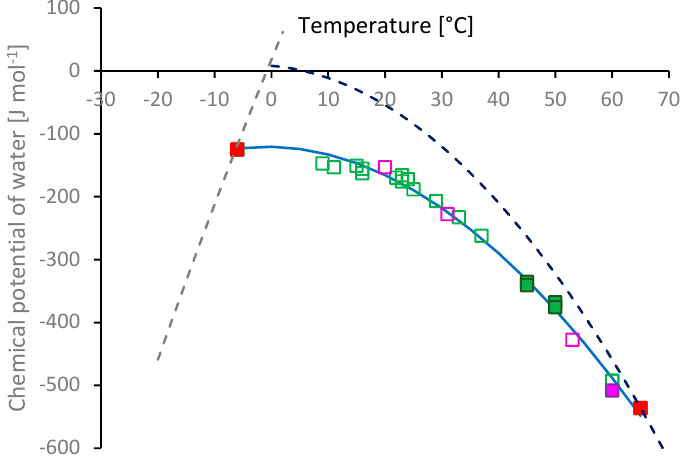
Figure 10. Chemical potential vs. temperature for ice (grey dashed, Equation (7a)), liquid water (blue dashed, Equation (7b)), cloud points in salt solutions (open squares) and the aggregation onset points observed by DLS or SAXS (filled squares). Green points were obtained for NaCl solutions; magenta indicates KCl solutions. The gelation points at high and low temperature, observed by rheology (red), are assumed to indicate where the chemical potential of the hydration shell is equal to that of water or ice. The uncertainty in the experimental data is expected to be similar to the sizes of the symbols. Subsequently, an estimate for the chemical potential of the hydration shell (blue line) was obtained by fitting Equation (8) to the turbidity and aggregation point data.